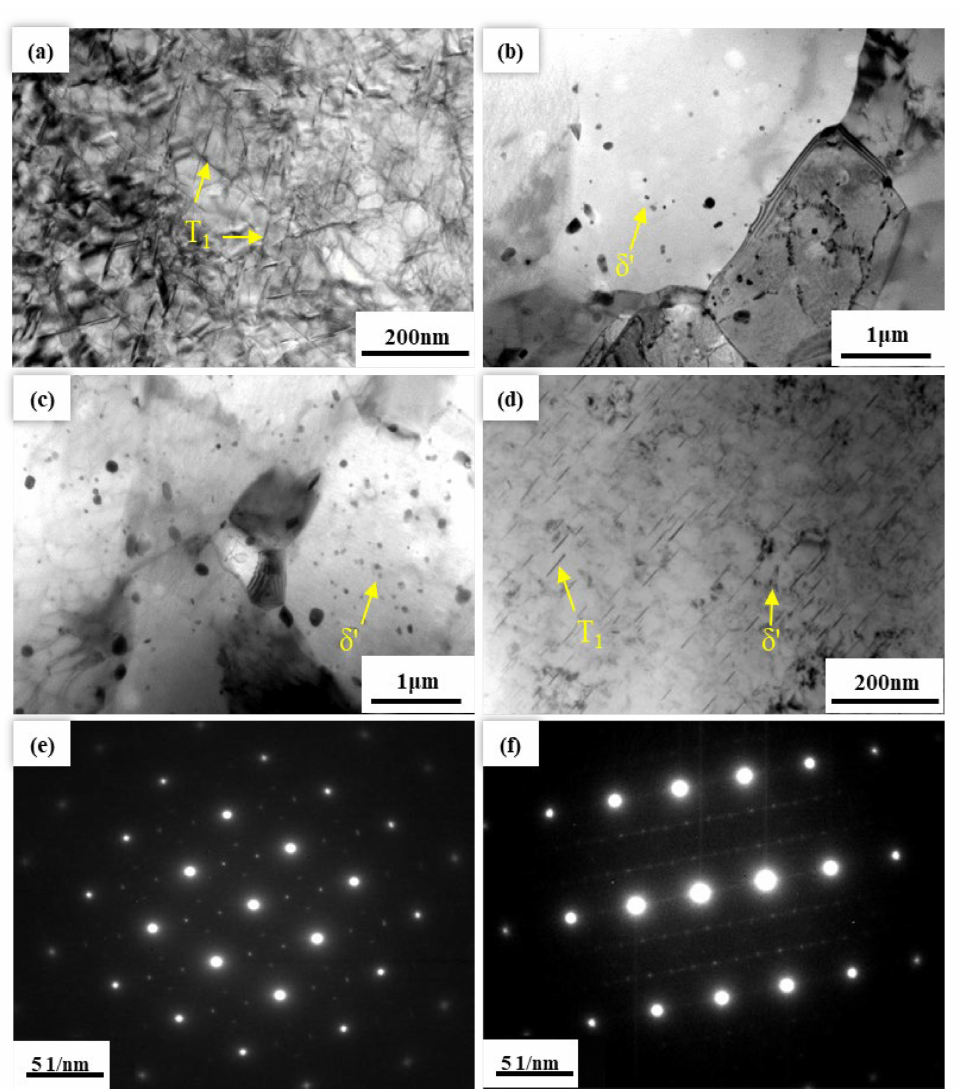
Figure 9. TEM observation of microstructure of ( a ) base metal; ( b , c ) nugget zone; ( d ) heat-affected zone. ( e ) SADPS for nugget zone [100]; ( f ) SADPS for nugget zone